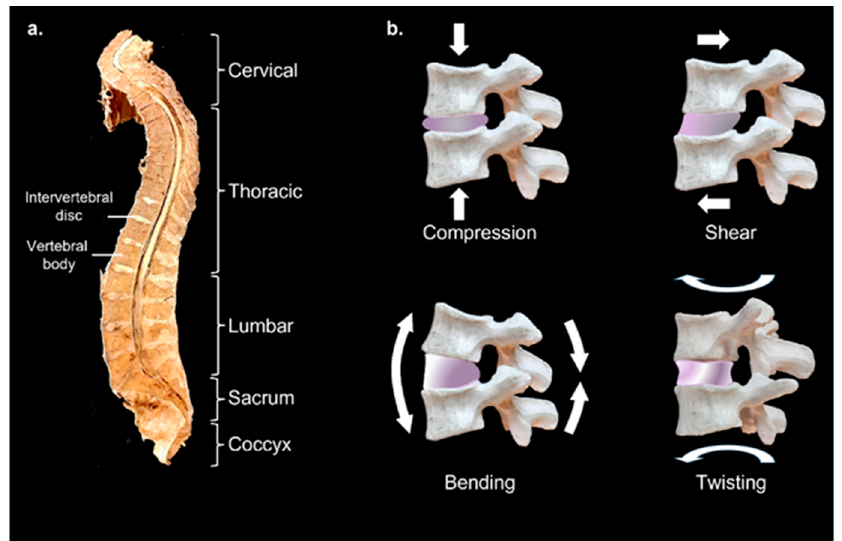
Figure 1. The human spine and intervertebral discs. ( a ) Median sagittal section of human spine showing white intervertebral discs between vertebral bodies. ( b ) Types of movement and forces intervertebral discs need to endure. Images prepared using material from the University of Otago, Anatomy Museum.